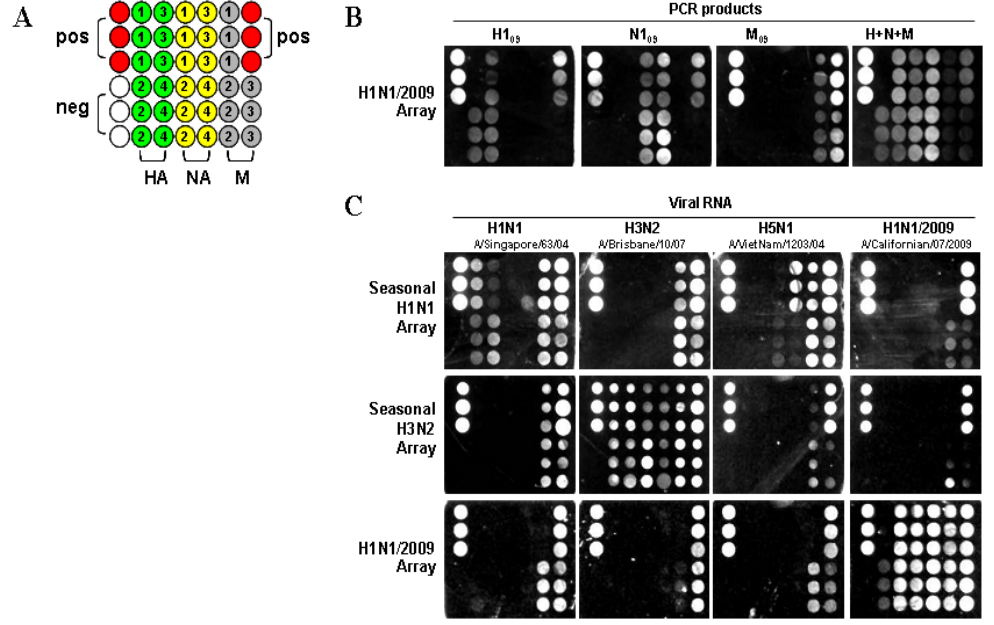
Figure 1. Image from a Verigene ID TM detection system. ( A ) Nanomicroarray layout with positive control capture (closed red circles), negative control (closed blank circles), M, HA, and NA gene captures (filled as variable color of closed circles, spotted in triplicate) are indicated. The numbers indicate the different capture sequences from a gene shown in Table 1. Three types of arrays for H1N1, H3N2, and H1N1/2009 are printed in the same format as indicated. ( B ) Silver staining image for individual or multiple H1N1/2009 PCR products are shown and labeled. ( C ) Silver staining image from 0.5 μ g of viral RNA